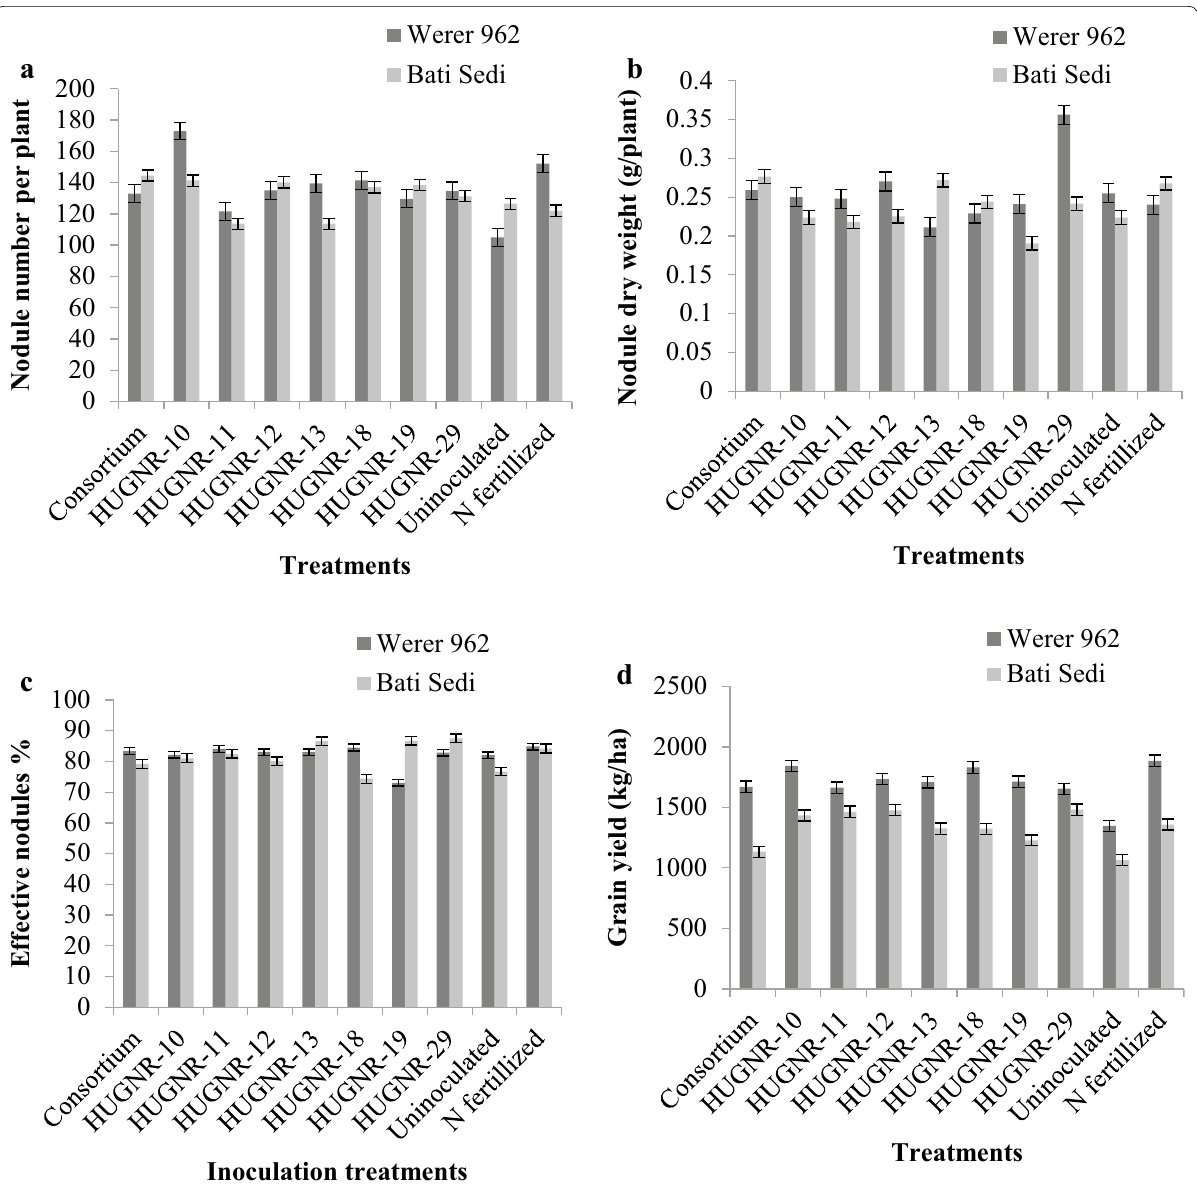
Fig. 2 Effect of Bradyrhizobium inoculation on a Nodule number, b Nodule dry weight, c Effective nodules % and d Grain yield of Bati-Sedi and Werer 962 cultivars of peanut at Babile and Fedis experimental